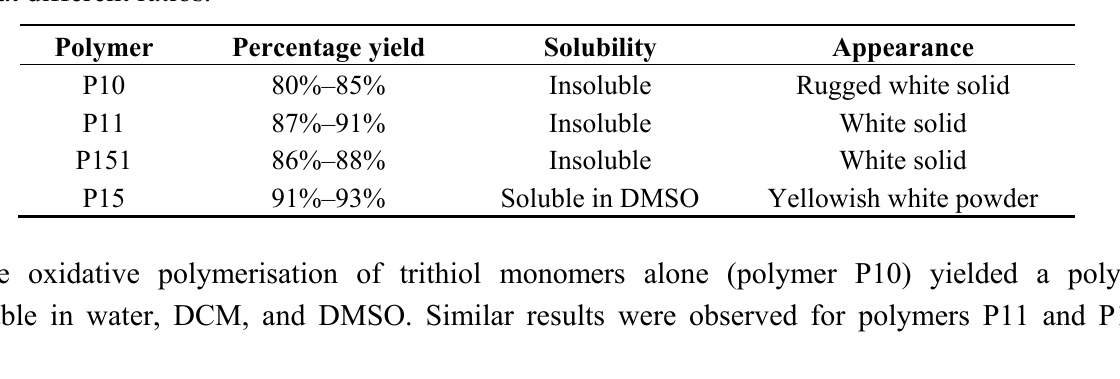
Table 1. Percentage yield, solubility, and physical appearance of the synthesised polymers at different